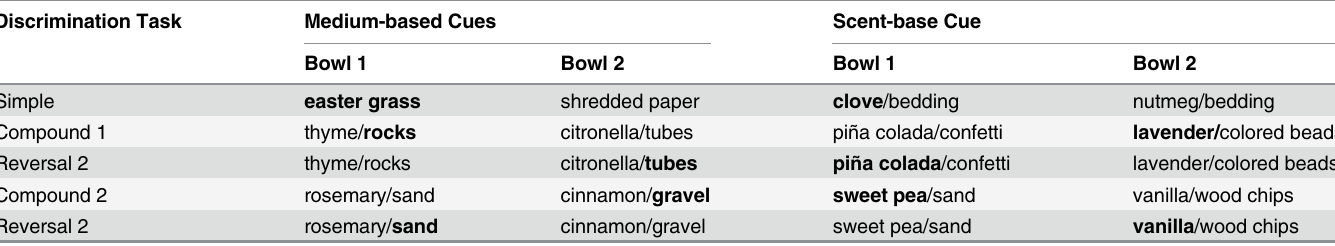
Table 1. Non-Spatial Discrimination Reversal Learning Examples Discrimination